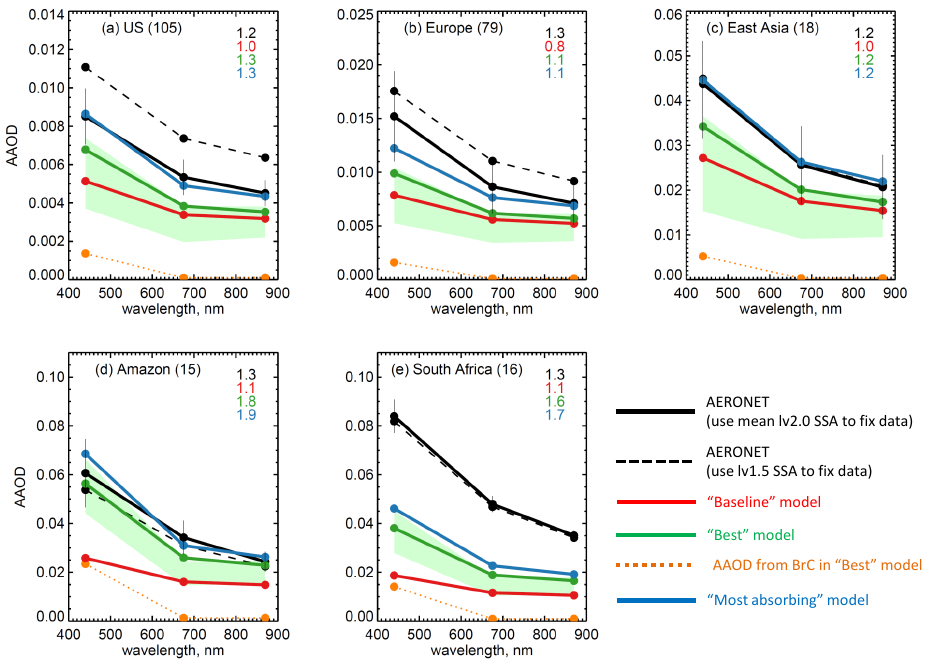
Figure 8. The regional mean wavelength-dependent AAOD at AERONET sites in (a) US, (b) East Asia, (c) Europe, (d) Amazon and (e) South Africa (regions defined by red boxes in Fig. 7). Averages are annual for (a–c) and for the fire season in (d–e) . The available number of sites averaged in each region are shown in brackets. Numbers at the upper-right corner of each panel indicate the absorption Ångström exponent (440nm/675nm). Observations are shown in black, with three model simulations: “baseline” (red), “best” (green), “most absorbing” (blue). The contribution from brown carbon is shown in brown. Error bars show the standard deviation of observed annual AERONET AAOD. Green shadings show the range of “best” modeled AAOD when changing BC properties independent of BC mass and absorption enhancement, see text for